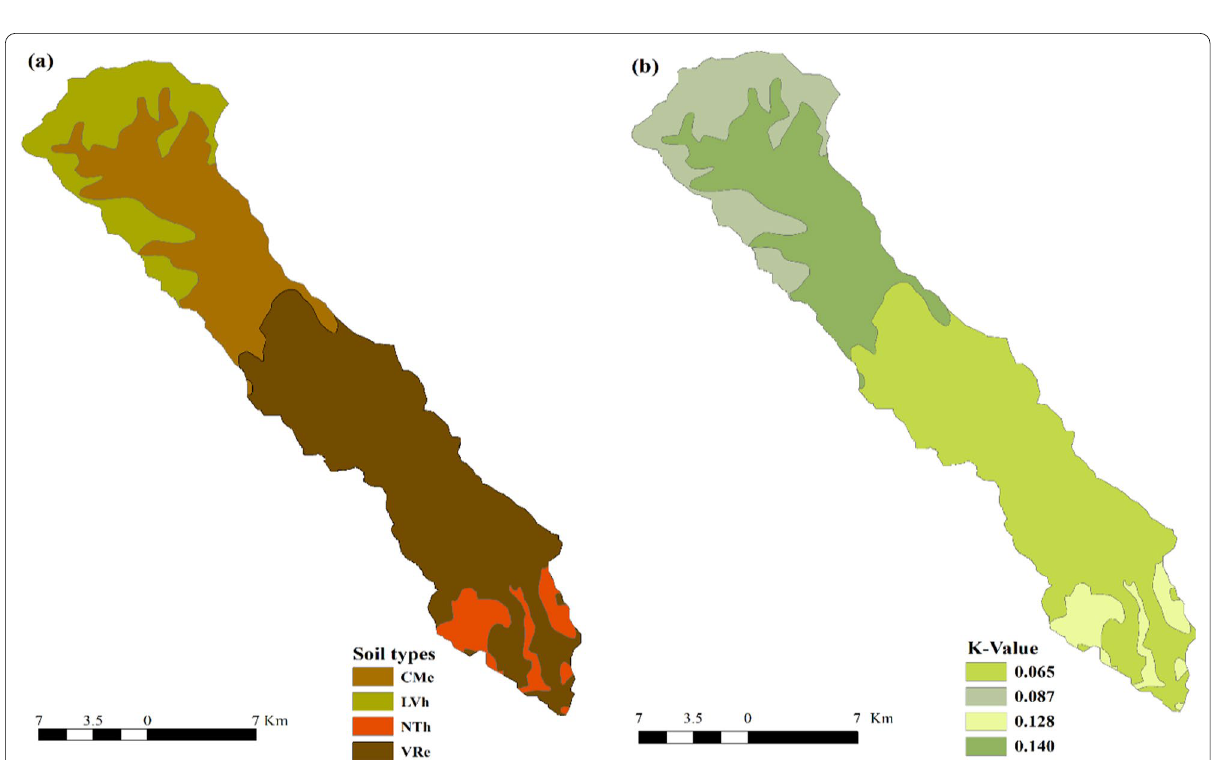
Fig. 4 Slope length and steepness factor ( LS -factor) map of Muga